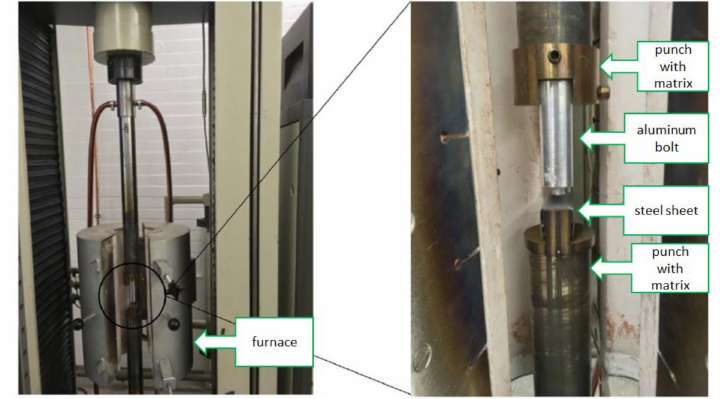
Figure 3. Test set-up for the production of metallic continuous